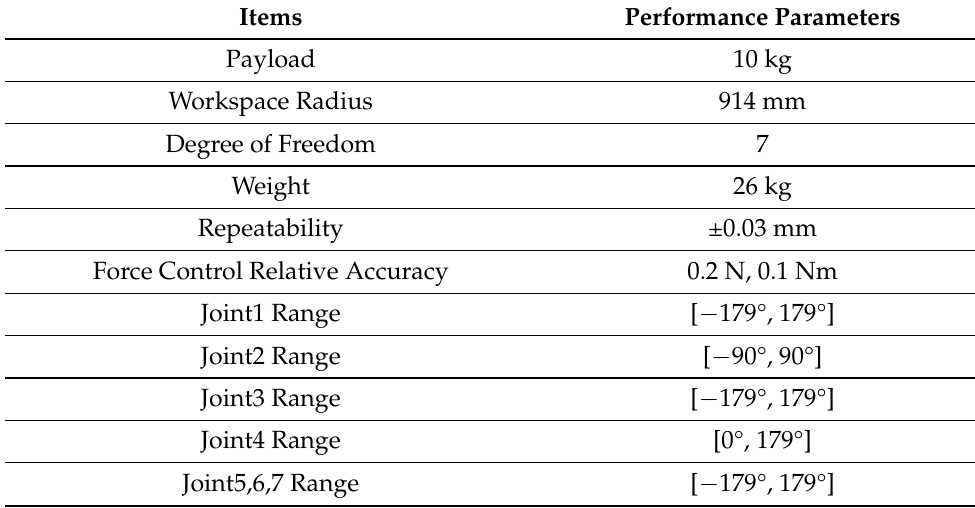
Table 1. Performance parameters of the manipulator.